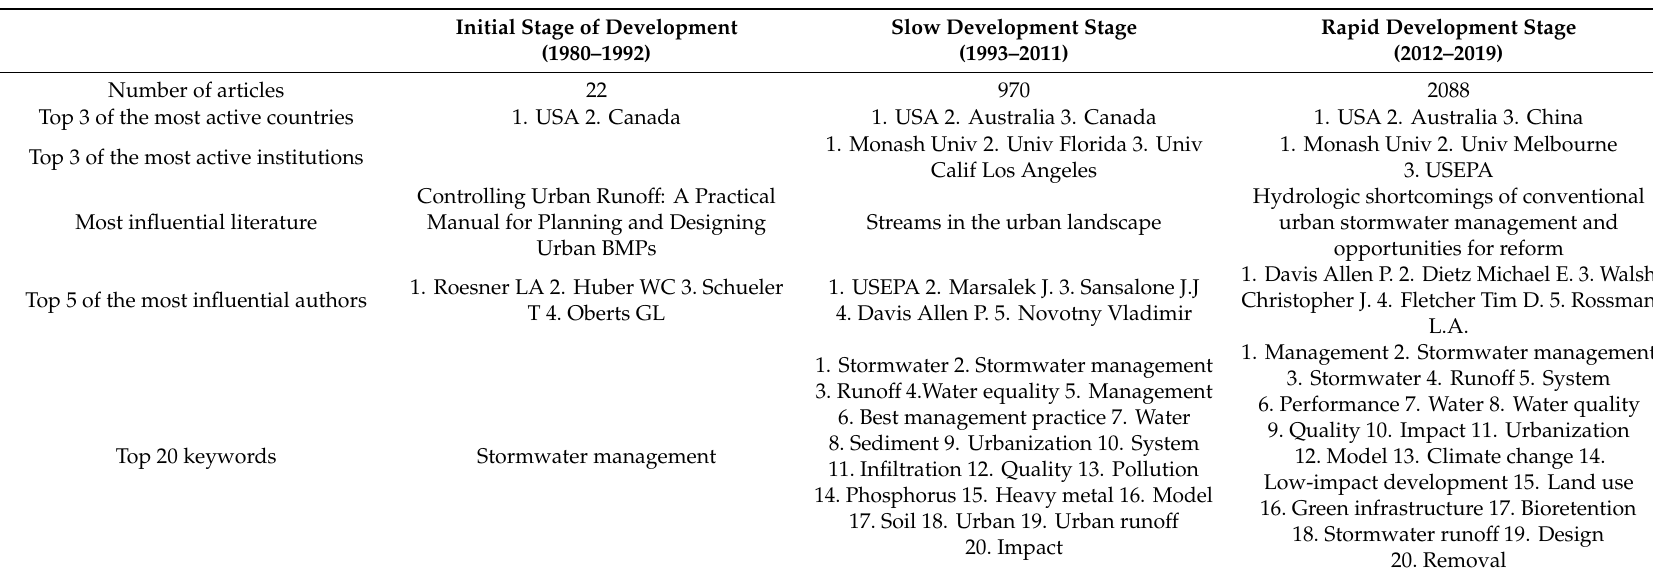
Table 5. Review stage in stormwater